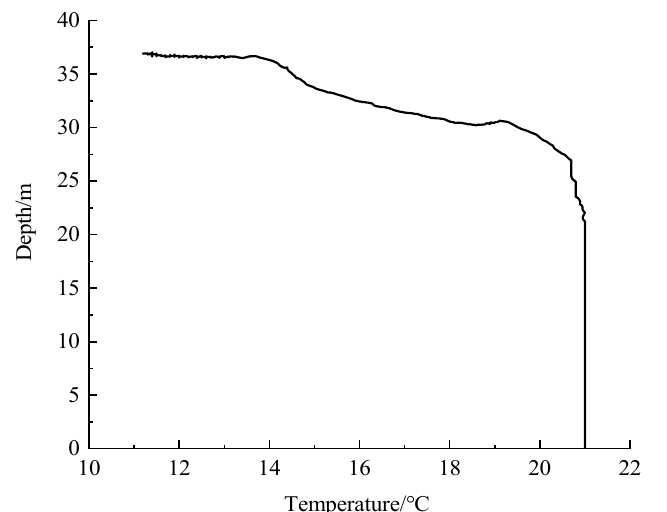
Figure 7. The lake test site.